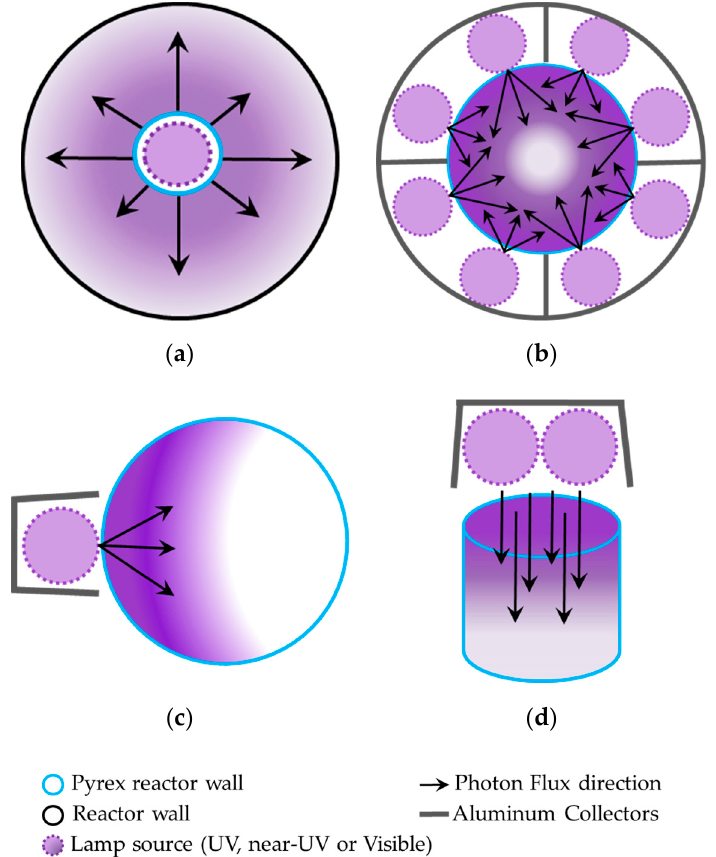
Figure 3. Representation of photocatalytic reactors with lamps placed at different positions: ( a ) internal-annular radial irradiation, ( b ) external-annular radial irradiation, ( c ) external-sided radial irradiation, and ( d ) top axial irradiation. These tubular reactors can also be implemented using rectangular geometries [11,22,79,80].